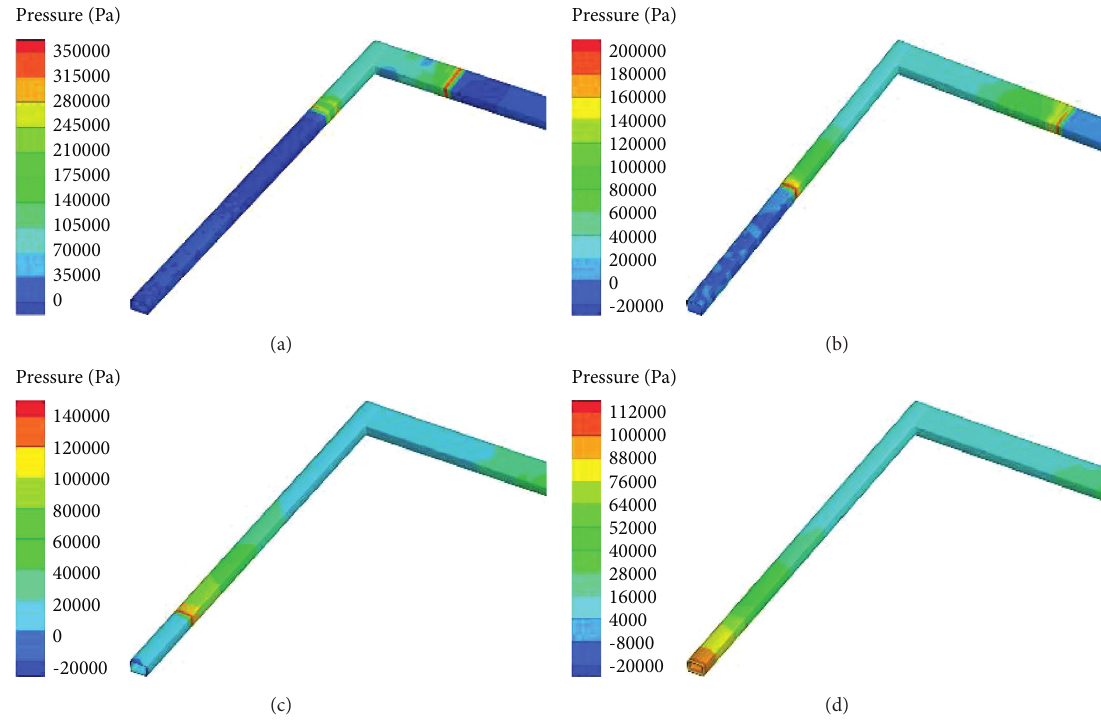
Figure 4: Cloud diagram of shock wave propagation at each moment: (a) t � 33.5ms; (b) t � 88ms; (c) t � 140ms; (d) t � 181 ms.